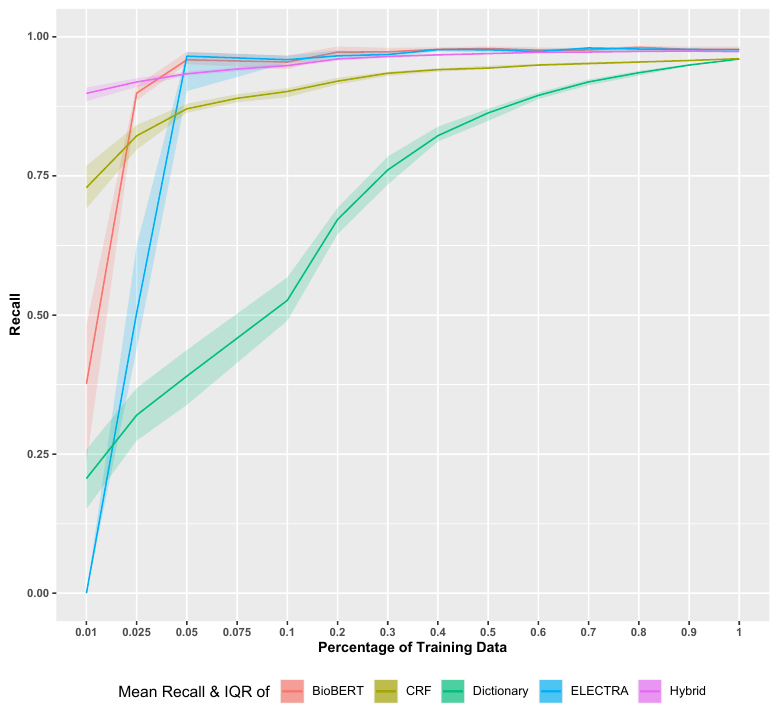
Figure 5. Learning curves based on recalls for the dictionary model, CRF model, hybrid model, BioBERT model and ELECTRA model. The line represents the mean F-score and shaded area represents the inter-quartile range (IQR).